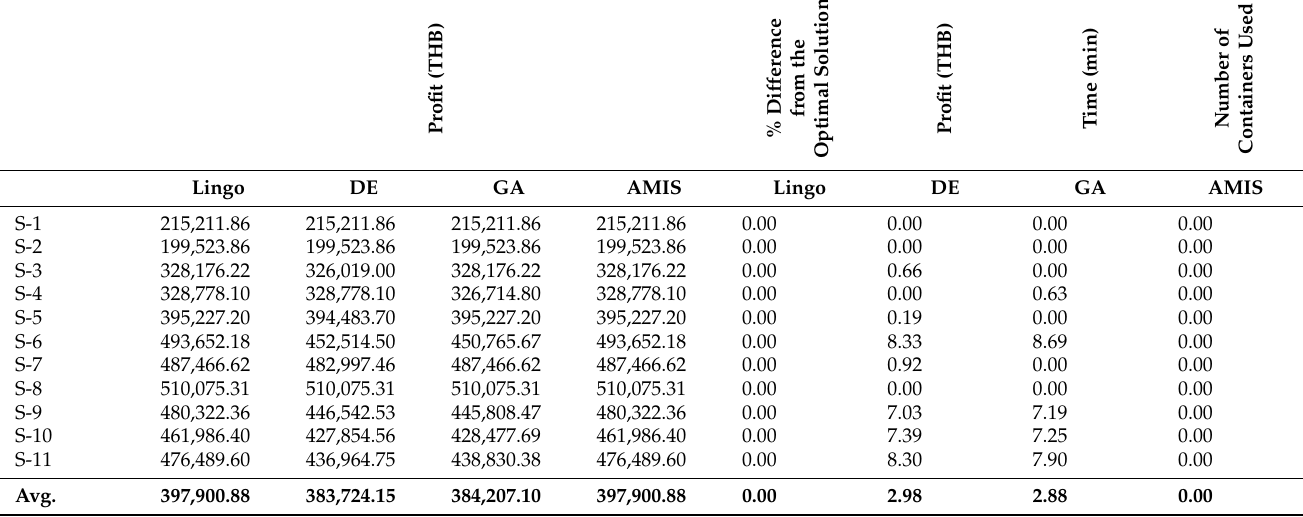
Table 13. Average profit per container of all